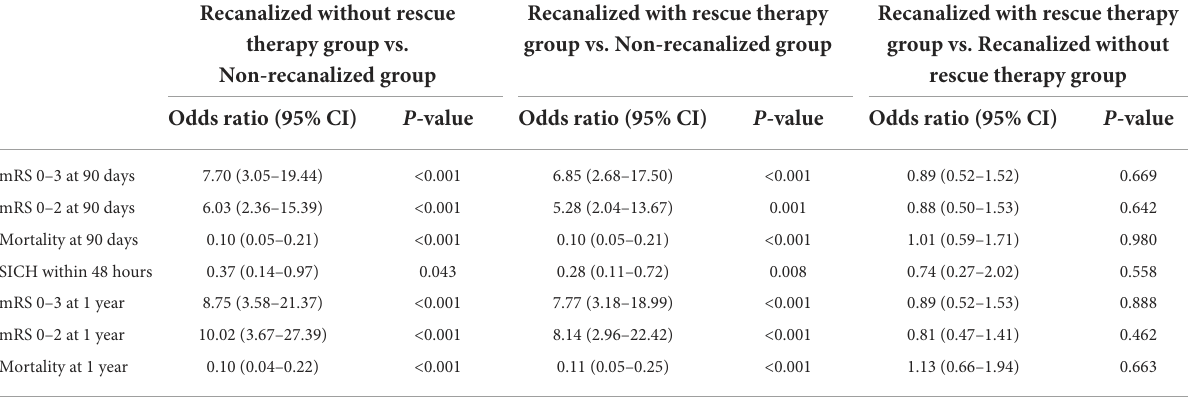
Recanalized with rescue therapy group vs. Recanalized without rescue therapy